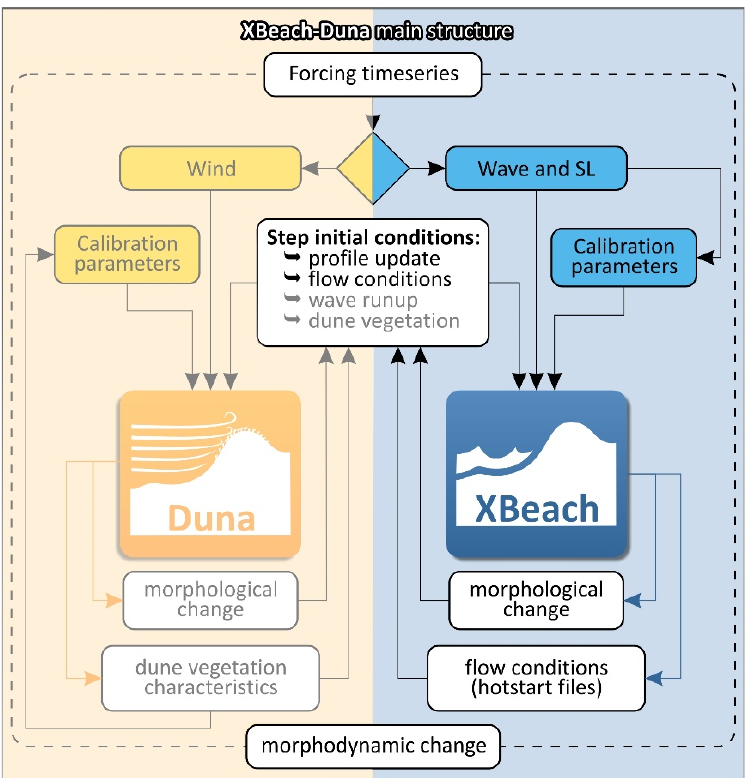
Figure 4. The coupled XBeach-Duna modelling approach: the left panel presents aeolian processes (disabled for the case of the Emma run) and the right panel shows marine processes and flow of inputs and outputs.